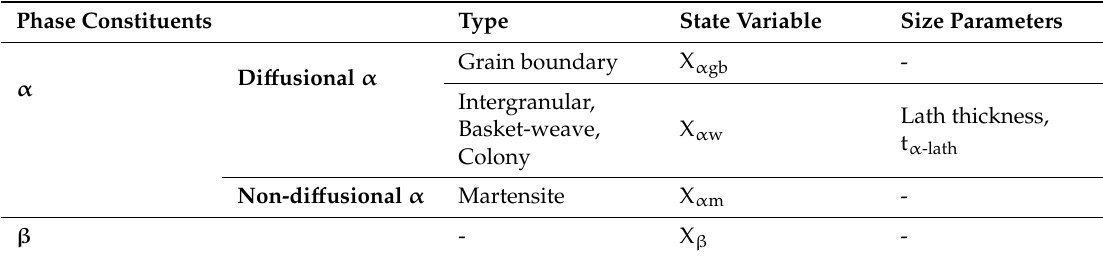
Table 2. Microstructural parameters and morphology description used in this work.